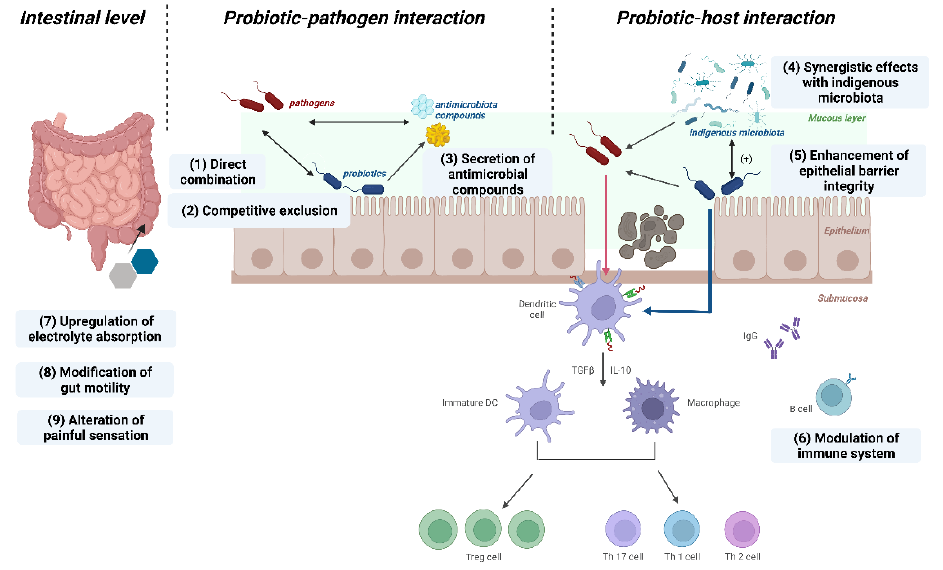
Figure 1. Predominant mechanisms of probiotic action. Probiotic-pathogen interactions in the middle part of the figure include three mechanisms: (1) direct combination, (2) competitive exclusion, (3) secretion of antimicrobial compounds; Probiotic-host interactions in the right part of the figure include three mechanisms: (4) synergistic effects with indigenous microbiota, (5) enhancement of epithelial barrier integrity, (6) modulation of immune system. At the intestinal level in the left part of the figure, probiotics have an effect through: (7) upregulation of electrolyte absorption, (8) modulation of gut motility, (9) alteration of painful sensations. (Figure was created with Biorender. com).